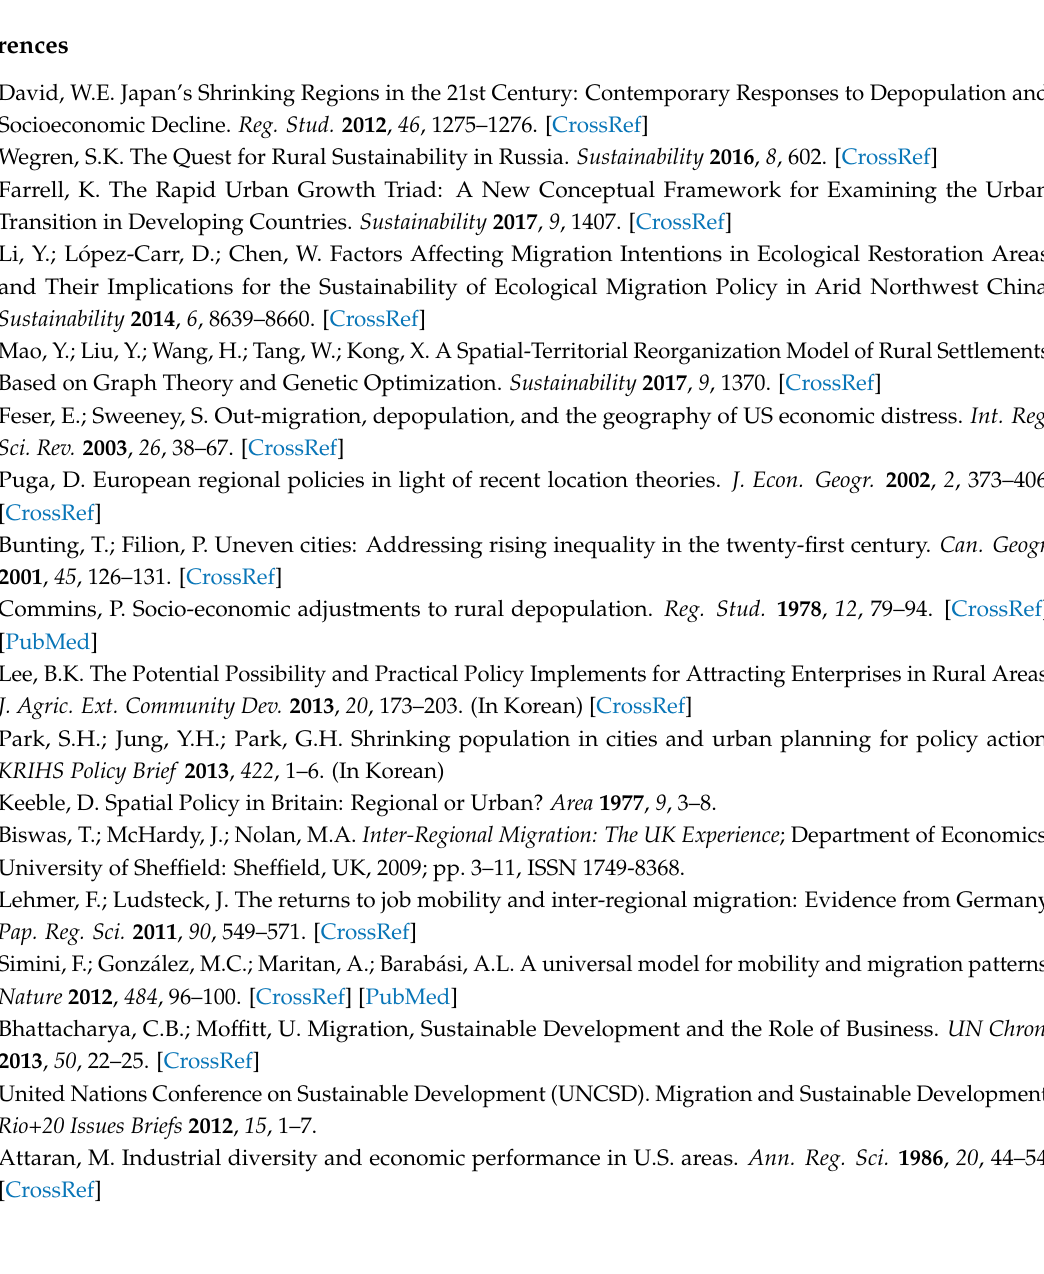
observed net-migration: ( a ) in 2011; and ( b ) during 2011–2015.